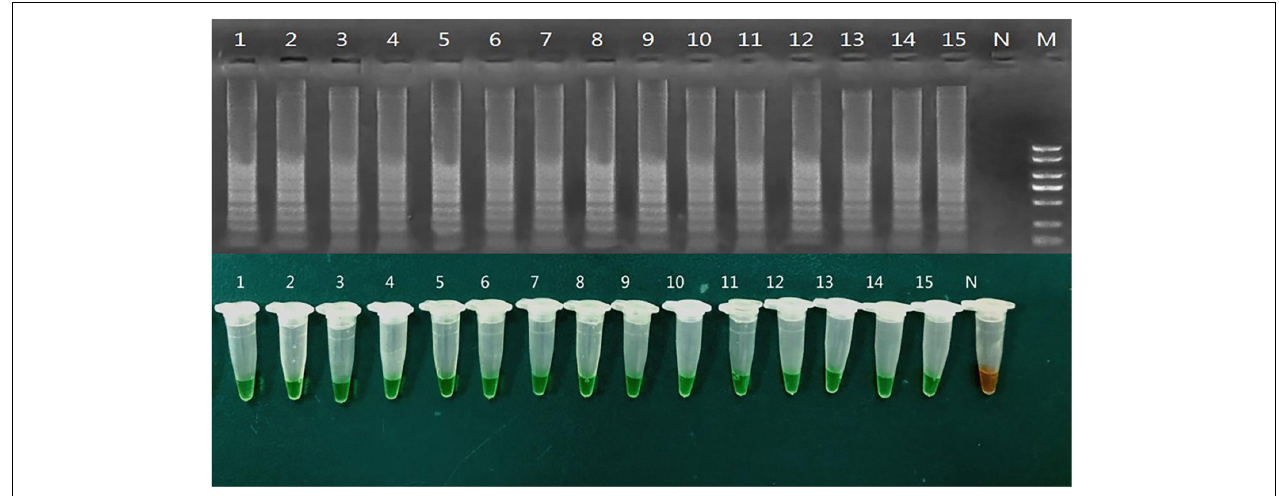
FIGURE 4 | Direct detection of peg-344 by LAMP in clinical samples. 1–15: as shown in Table 3 N: Klebsiella pneumoniae ATCC700603.